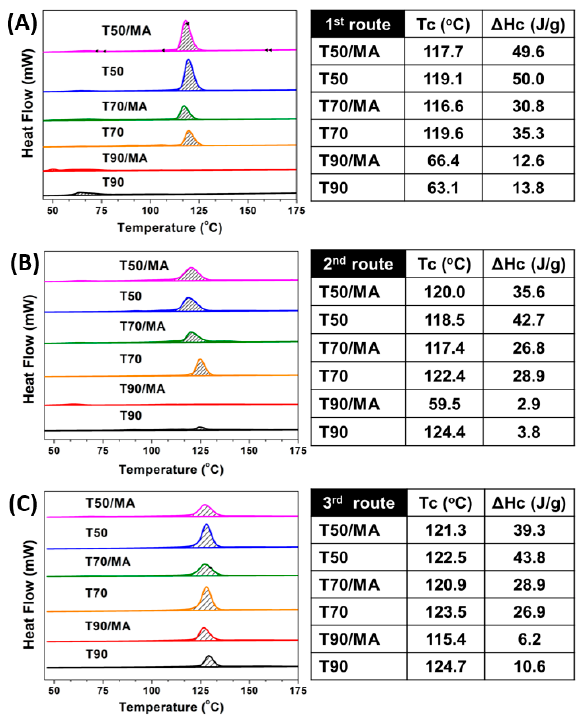
Figure 7. Crystallization behaviors in DSC performance of T/P and T/P/MA groups as related to melt- recycling: ( A ) one-off hot-pressing, ( B ) the post-2nd-recycling, and ( C ) the post-3rd-recycling. ** Tc is crystallization temperature and Δ Hc is crystallization enthalpy.